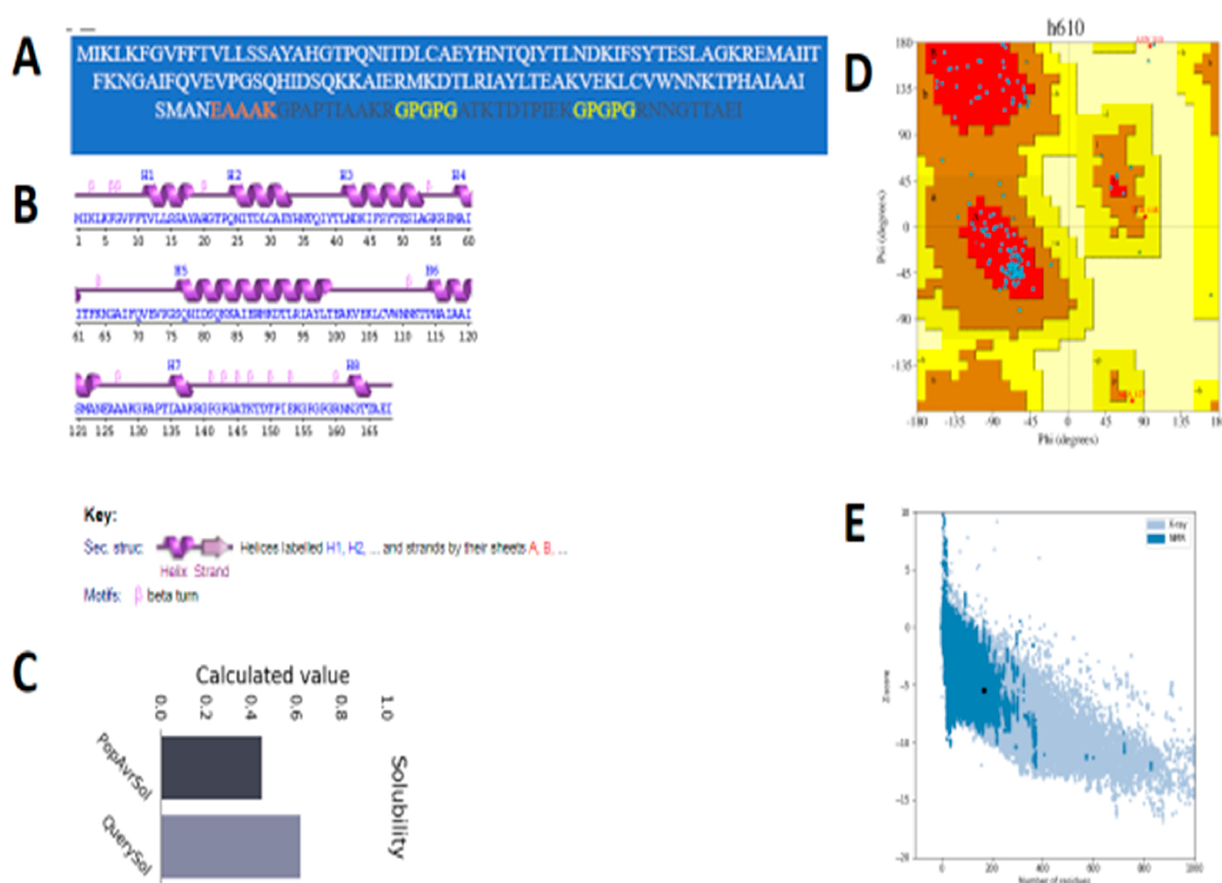
Figure 7. ( A ) Sequence of the vaccine construct. ( B ) Secondary structure. ( C ) Solubility prediction graph. ( D ) Ramachandran plot. ( E ) Z-score graph of the vaccine construct. The different color squares in the Ramachandran plot can be interpreted at the pdbsum generate website. The Z-score plot demonstrates the vaccine Z-score (represented by a black dot against blue and light blue shaded areas, which show the pdb structure of the same size).